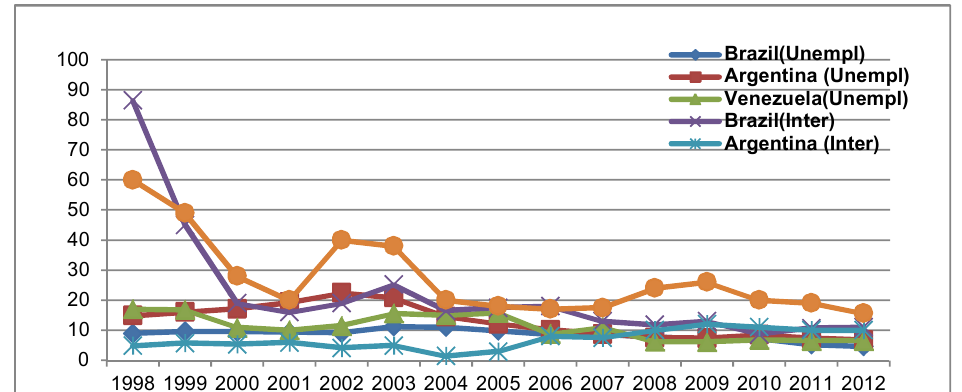
Figure 8: Unemployment and Interest Trends of